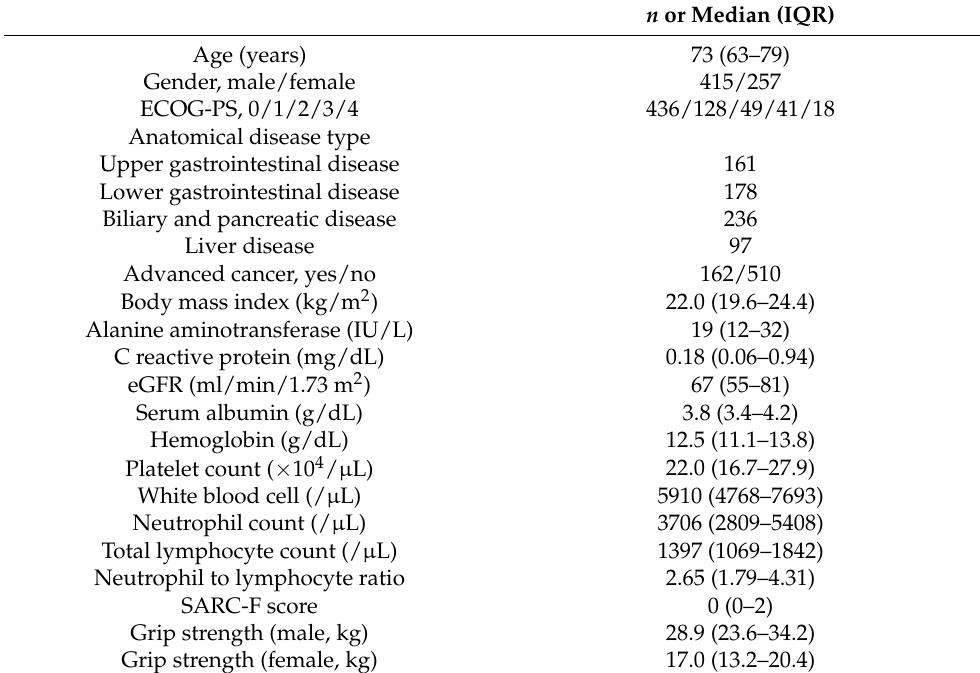
Table 1. Baseline characteristics ( n =